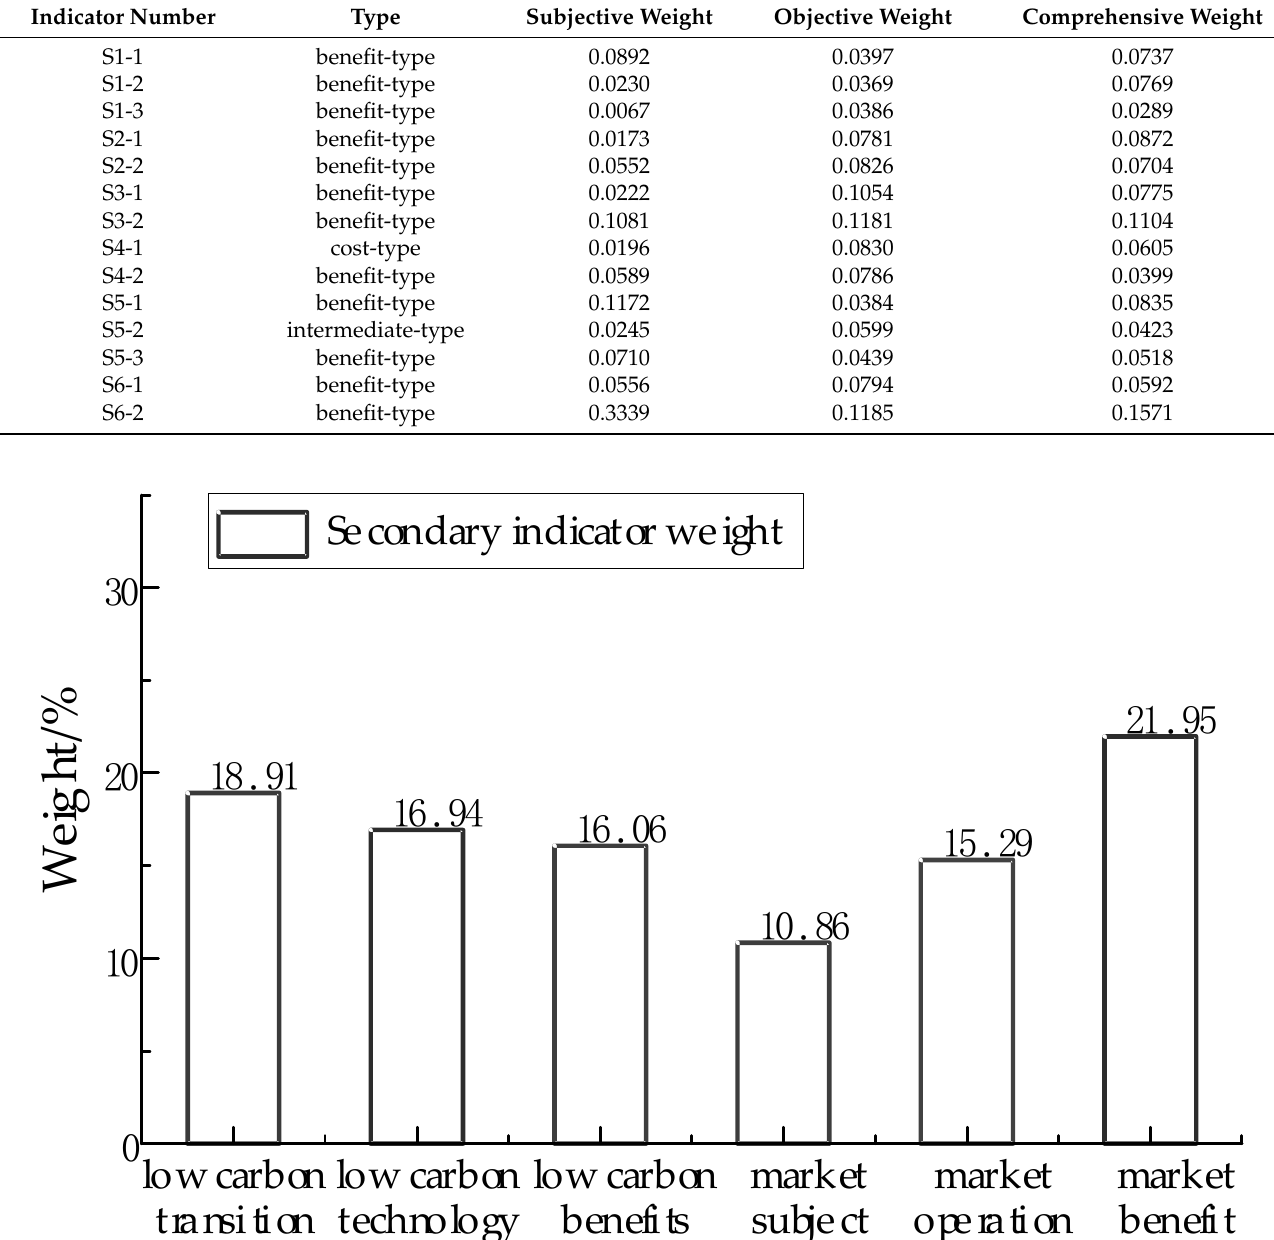
Figure 8. Weight distribution of secondary indicators.